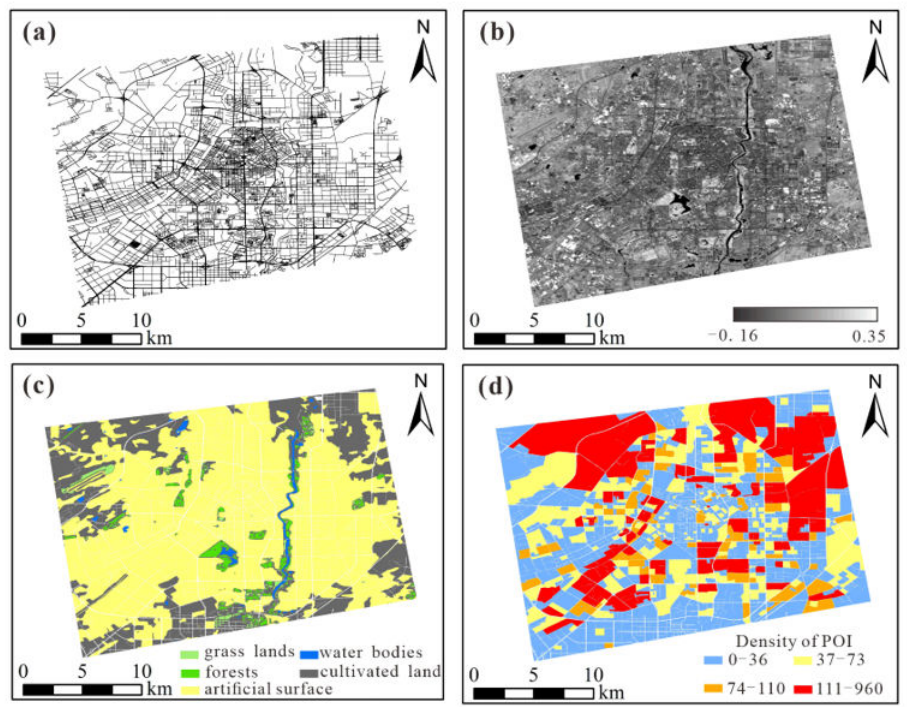
Figure 3. Distribution of land features data in parcel level: ( a ) road networks (Open Street Map, OSM); ( b ) normalized di ff erence vegetation index (NDVI); ( c ) land use data; ( d ) density of point of information